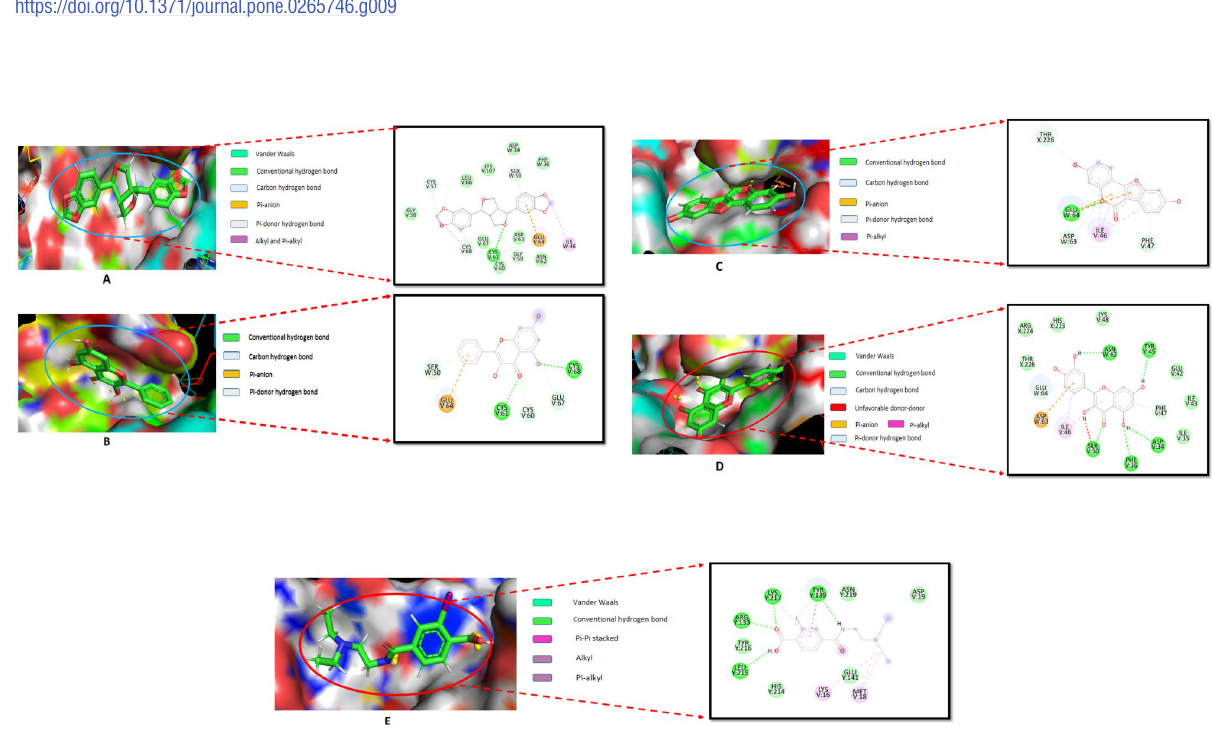
Fig 10. Molecular interactions of selected compounds against VEGFA (PDB ID: 1FLT) of (A) sesamin, (B) galangin, (C) coumestrol, (D) quercetin and (E) control. All selected compounds interact with the vital substrate management catalytic site.